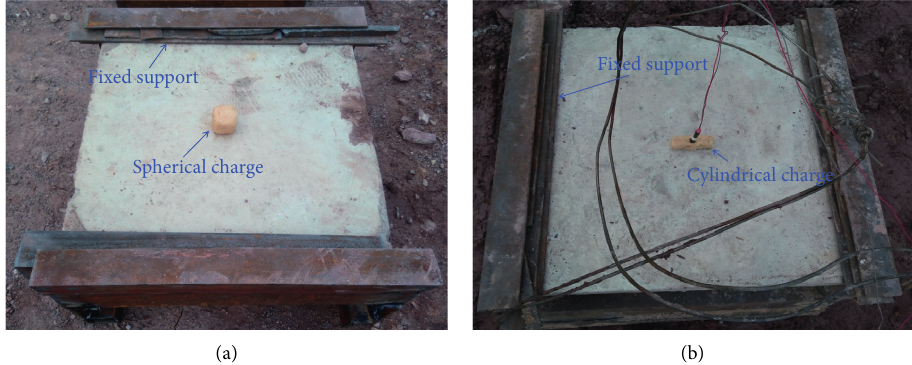
Figure 11: Air contact blast tests setup. (a) Spherical explosive. (b) Cylindrical explosive.